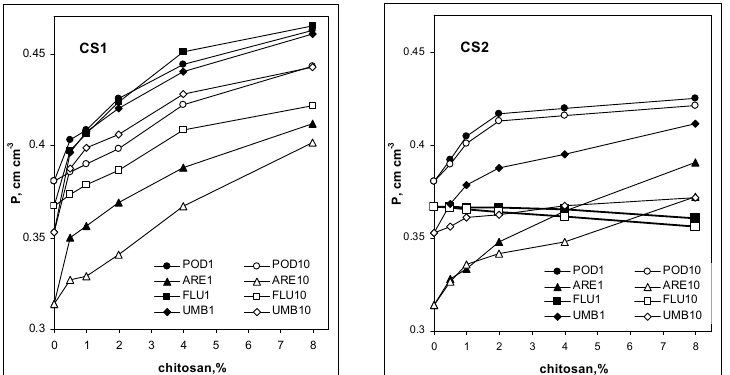
Figure 5. Dependencies of the porosity (P) of soil aggregates on the amendment of the studied chitosan (CS1 and CS2). The soils are abbreviated as: POD—Podzol, ARE—Arenosol, FLU—Fluvisol, UMB—Umbrisol. The number after the soil abbreviation shows the number of wetting–drying cycles applied to soil aggregates. Error bars are covered by the labels of the points.